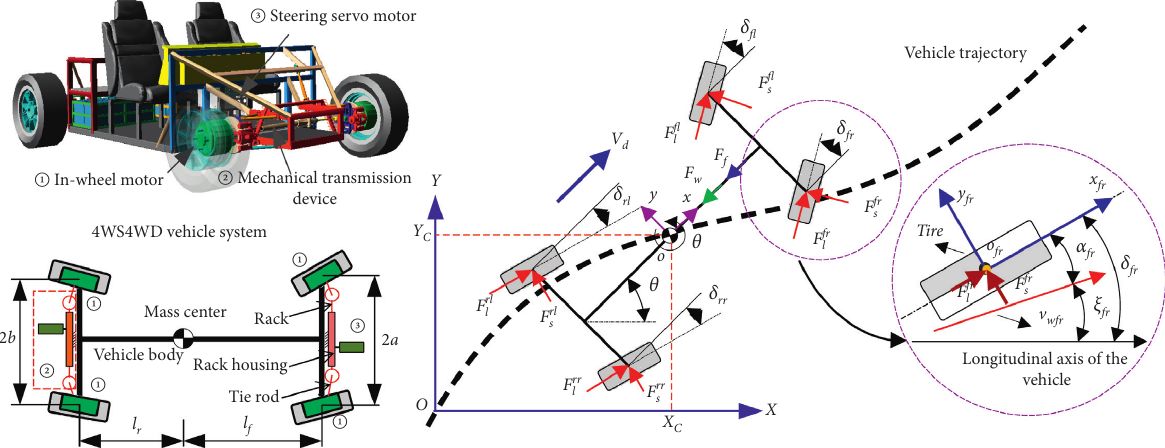
Figure 1: Schematic of a 4WS4WD vehicle system